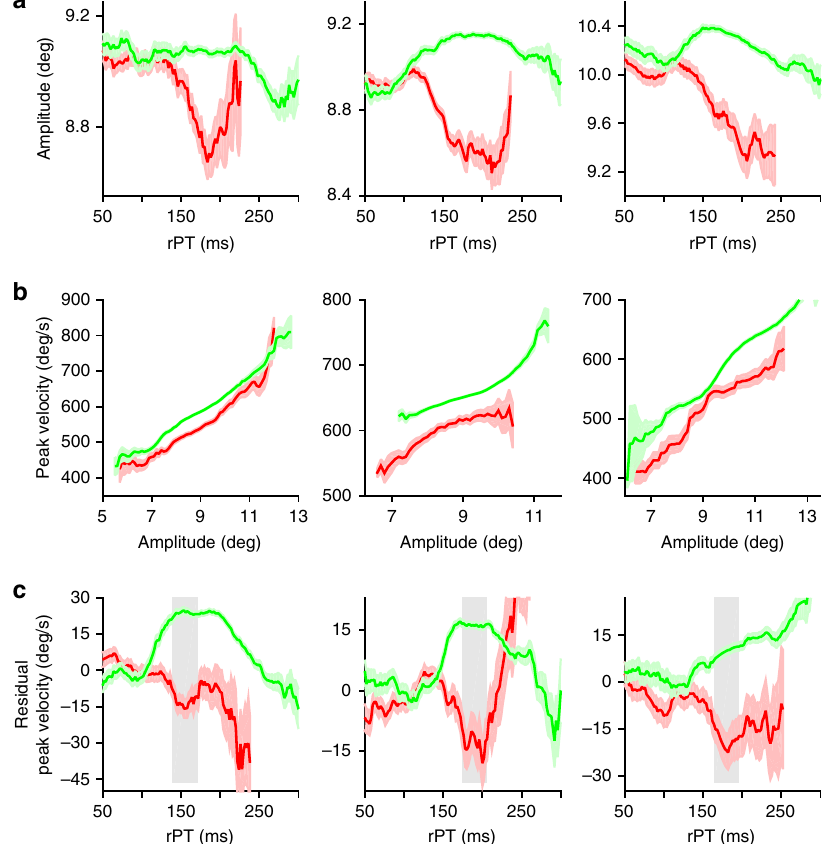
Fig. 5 Peak velocity and amplitude are independently modulated by rPT. a Mean saccade amplitude (±1 s.e.m.) of correct (green) and incorrect (red) saccadic choices as a function of rPT. b Mean peak velocity (±1 s.e.m.) as a function of amplitude (main sequence) of a subset of correct (green) and incorrect (red) long-rPT saccadic choices. c Mean residual peak velocity (rpv) ± 1 s.e.m. as a function of rPT. Trials plotted in b correspond to those shaded gray in c . Data are from monkeys R, T, and G (left to